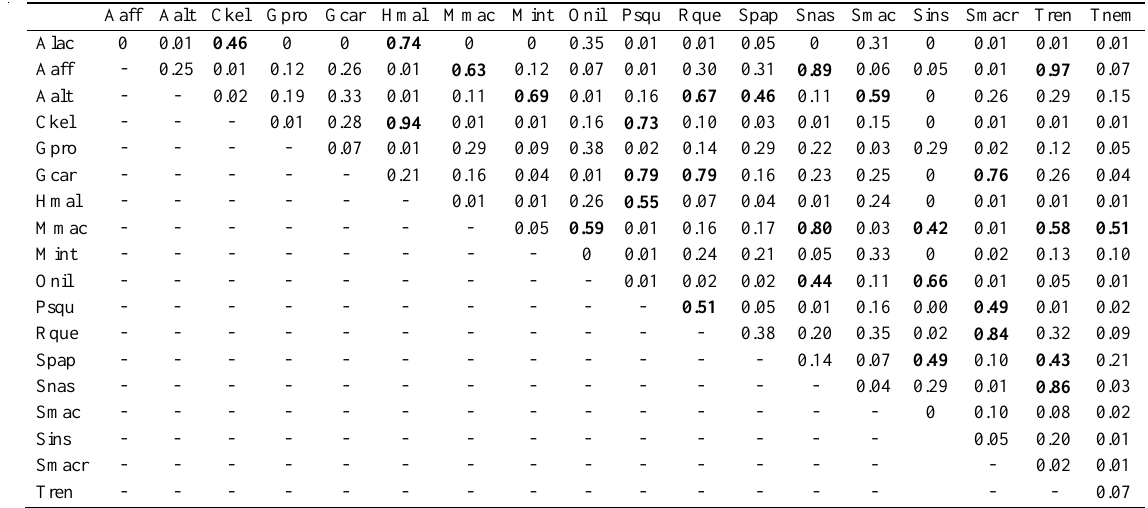
Table 2. Feeding overlap (Pianka’s Index) between fish species from the fish community of Nova Avanhandava Reservoir. In bold = intermediate ( > 0.40) and high (> 0.60)